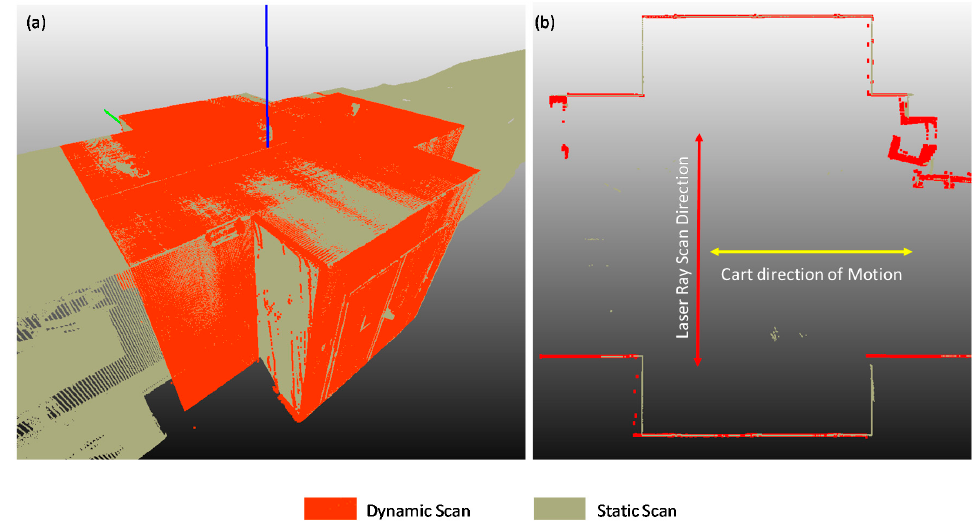
Machines 2017 , 5 , 32